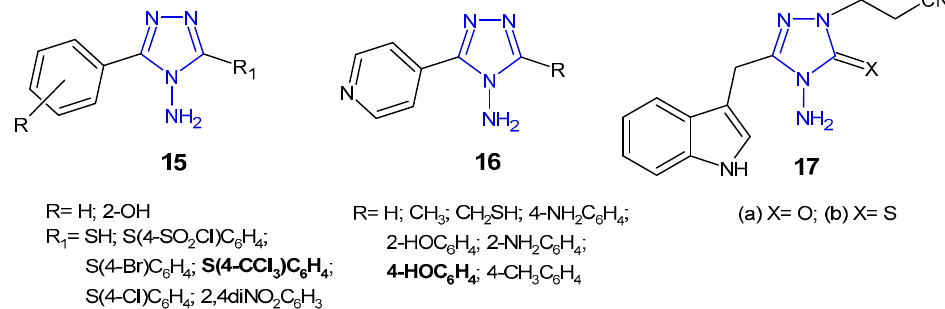
Figure 8. Antibacterial derivatives of 4-amino-1,2,4-triazole. Muthal et al. (2010) synthesized 5-substituted-3-pyridin-4-yl-1,2,4-triazoles 16